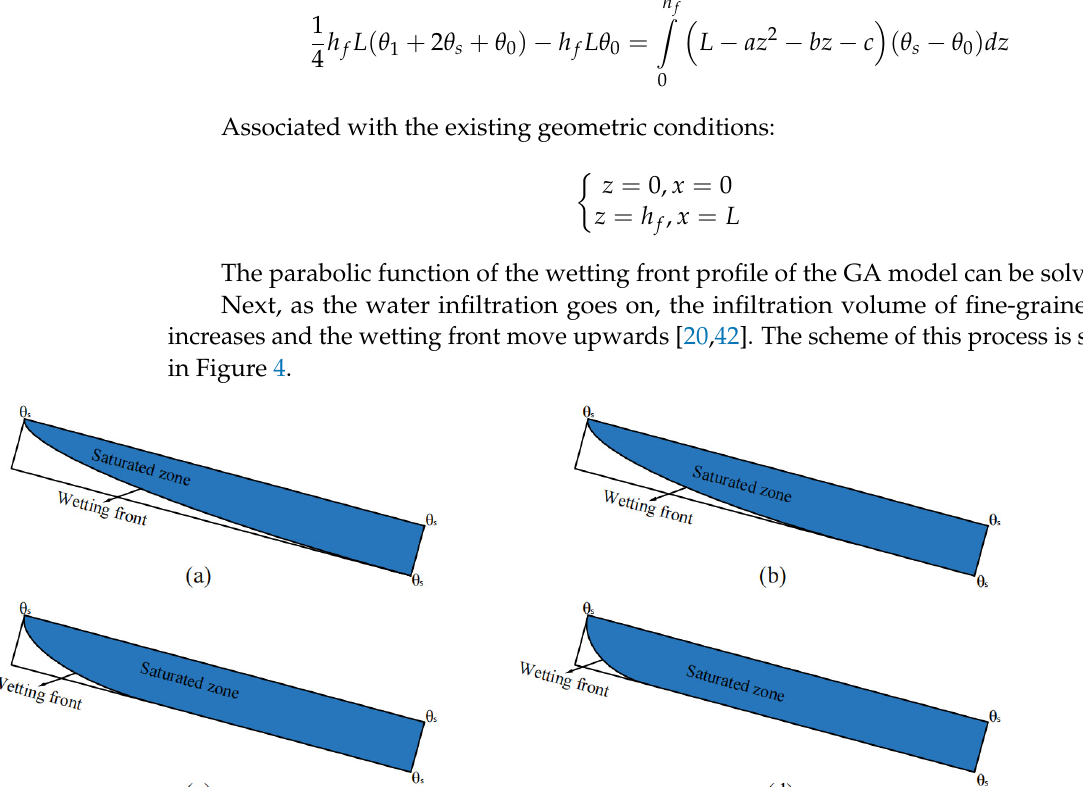
6 of 18 Figure 3. The scheme of water content distribution at the breakthrough time of fine-grained soil. Where,